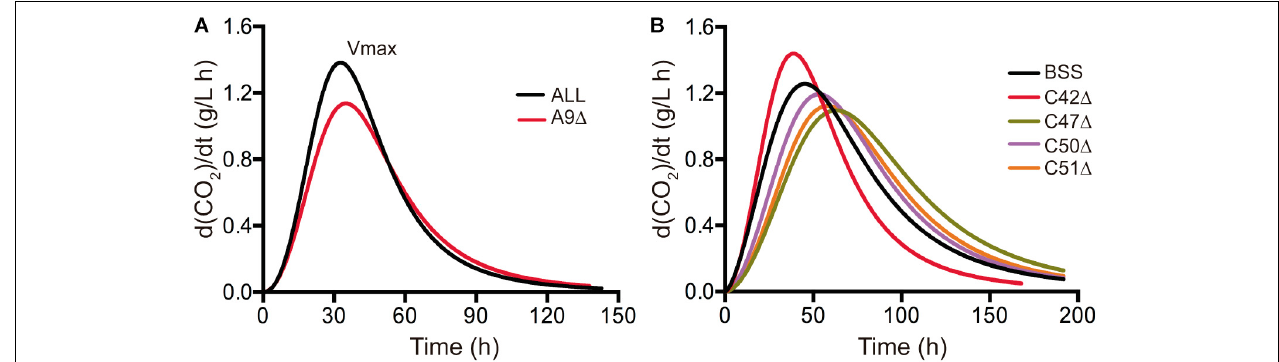
FIGURE 5 | Maximal CO 2 production rate of strains carrying deletions in horizontally acquired genes. Strains carrying single deletions in different horizontally acquired genes and showing statistically significant differences ( t -test, p < 0.05) with respect to the wild type phenotype are shown for region A (A) and region C (B) . Small scale fermentations in 150 mL of SM300 medium were performed for each strain and CO 2 release was measured as weight loss every 24 h. The CO 2 release curves were fitted to a sigmoid non-linear regression and the first derivative was calculated to obtain the maximal CO 2 production rate (Vmax, peak of the curves). The average values of three biological replicates are